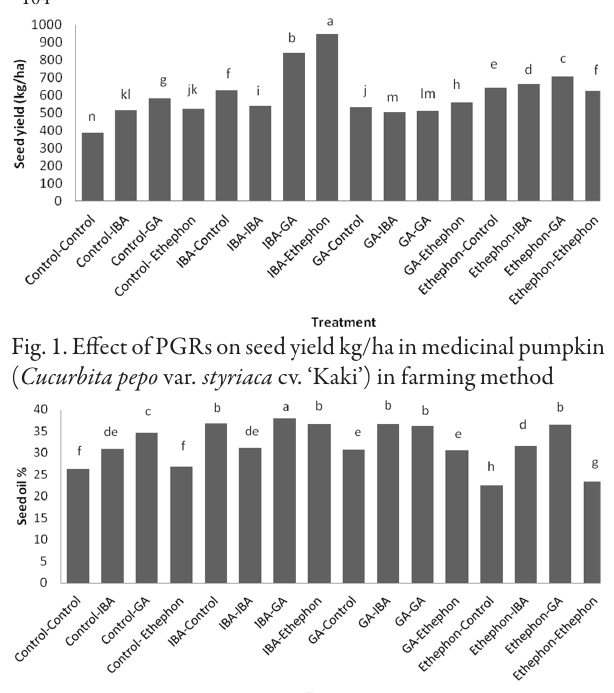
Fig. 2. Effect of PGRs on seed kg/ha of oil% of medicinal pump- kin ( Cucurbita pepo var . styriaca cv. ‘Kaki’) in farming method